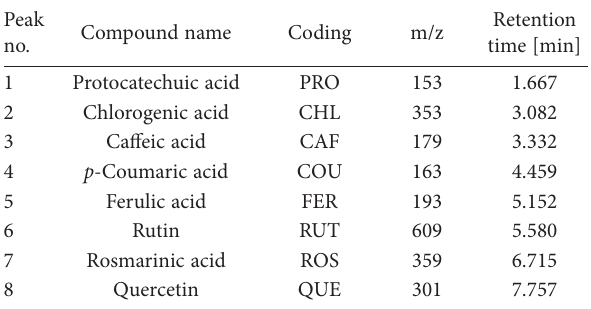
Table 3. Retention times for all reference compounds.